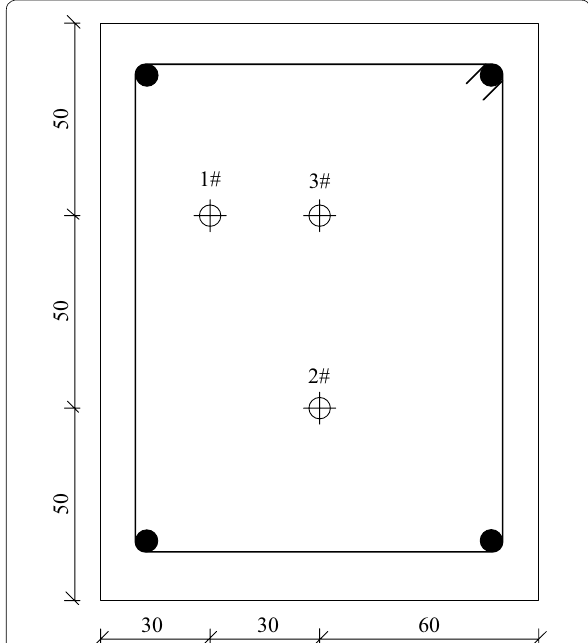
Fig. 5 Temperature measuring points on the RC beams